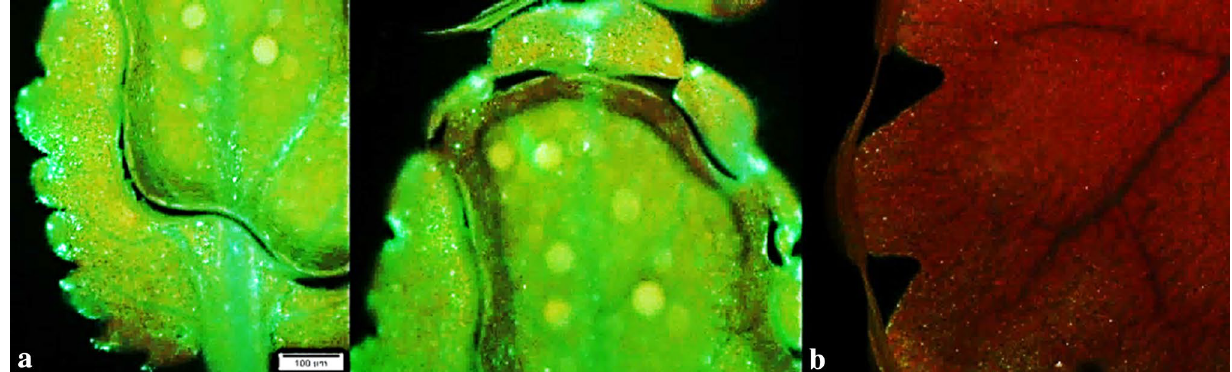
Figure 8. Green Fluorescence emission of green leaves from greenhouse-grown putative transgenic plants, ( a ) leaf sample from putative transgenic plant, ( b ) leaf segment of a wild-type plant (non-transgenic).